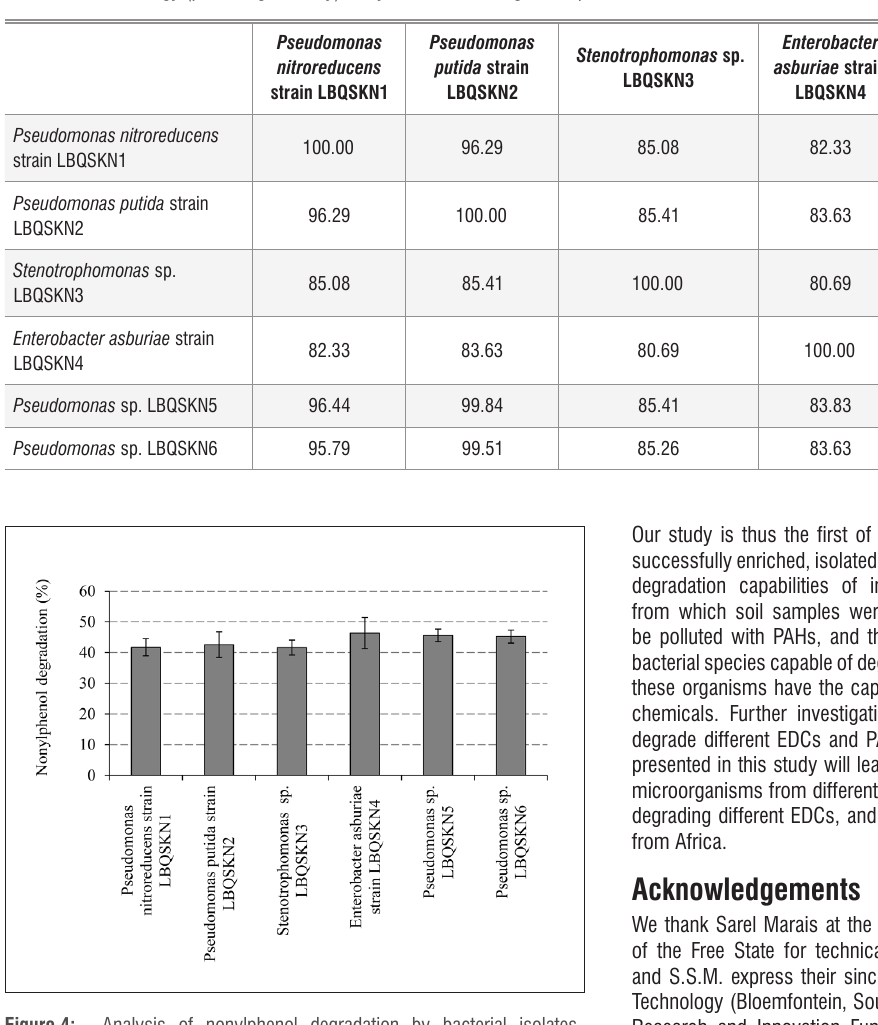
Figure 4: Analysis of nonylphenol degradation by bacterial isolates. Percentage degradation of nonylphenol by bacterial isolates was related to the control nonylphenol, which was taken as 100% as described elsewhere 35,36 . The values represent mean±s.d. for three biological replicates. Percentage degradation among different bacterial isolates was found to be not statistically significant (0.2< p <0.7).